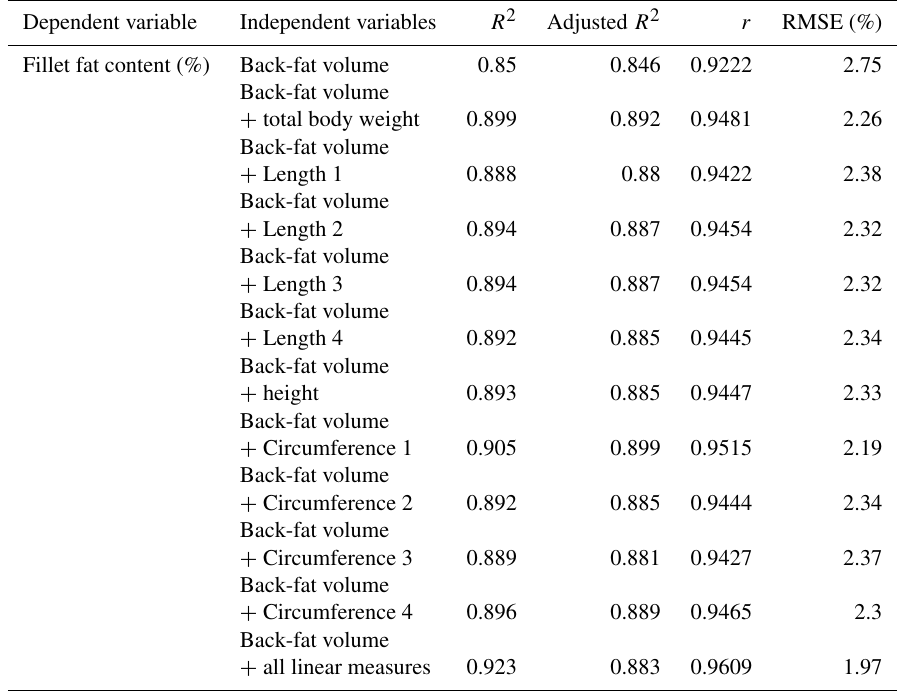
Table 6. Results of multiple linear regression for fillet fat content (%) and back-fat volume (cm 3 ) with the addition of linear measurement ( n = 33, p < 0 . 001).